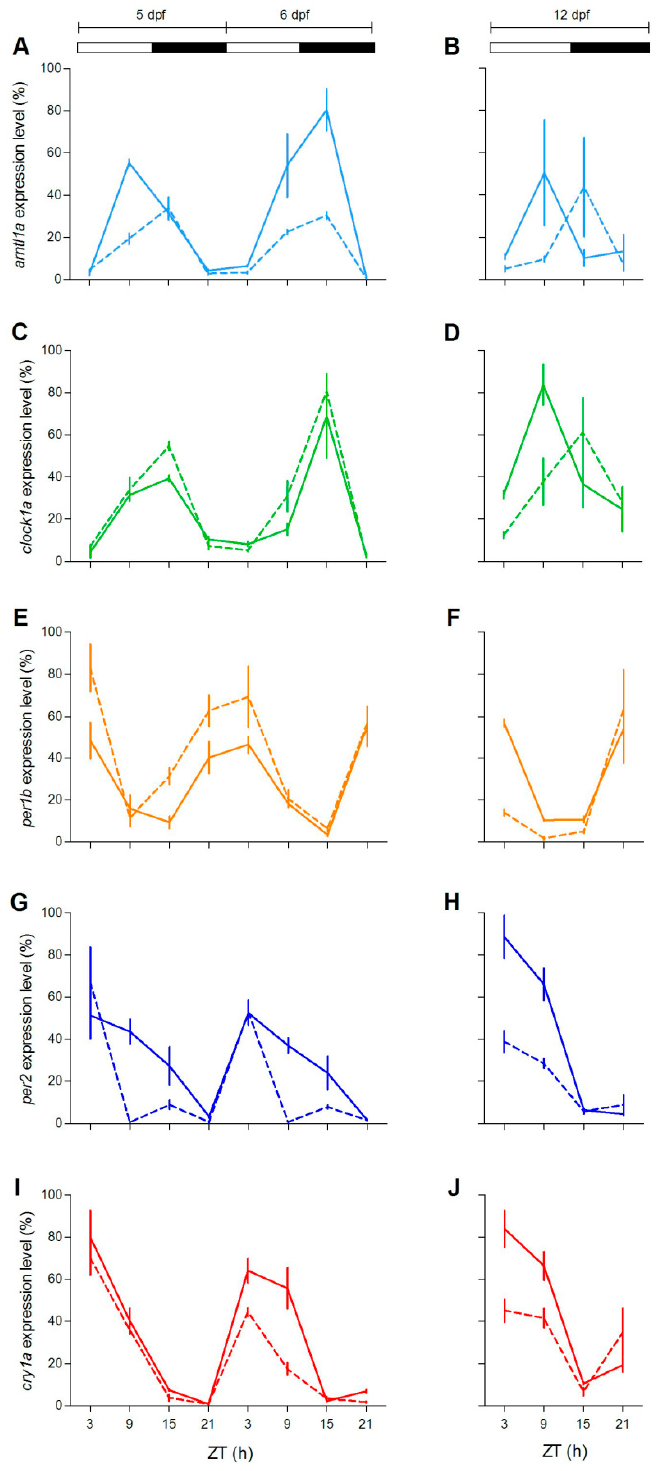
Figure 4. Daily expression levels of clock genes in zebrafish larvae. Quantitative polymerase chain reaction (qPCR) analysis of clock and light-regulated clock gene expression at 5–6 dpf ( A , C , E , G , I ) and 12 dpf ( B , D , F , H , J ) in zebrafish larvae exposed to LD cycles. For all panels, each point represents the mean ± SEM (n = 4). On the y-axes are plotted relative expression levels (100% is the maximum level detected for each gene in all dpf), while on the x-axes time is expressed as zeitgeber time (ZT, where ZT0 represents lights on). White and black bars represent light and dark periods, respectively. gr +/+ = solid line; gr − / − = dotted line.